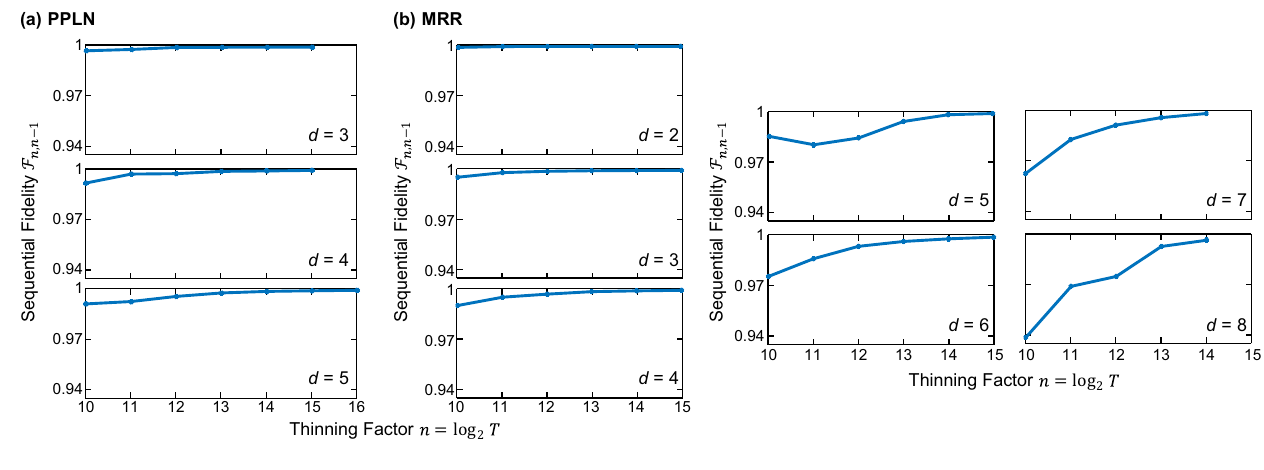
Fig. 6 | Convergence diagnostics. Sequential fi delity vs. thinning factor n = log 2 T for all dimensions for BFC states generated from a PPLN and b